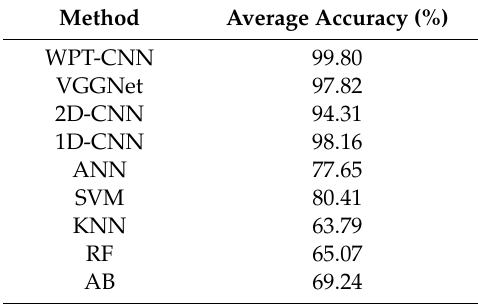
Table 12. Comparison result on Dataset A in Case